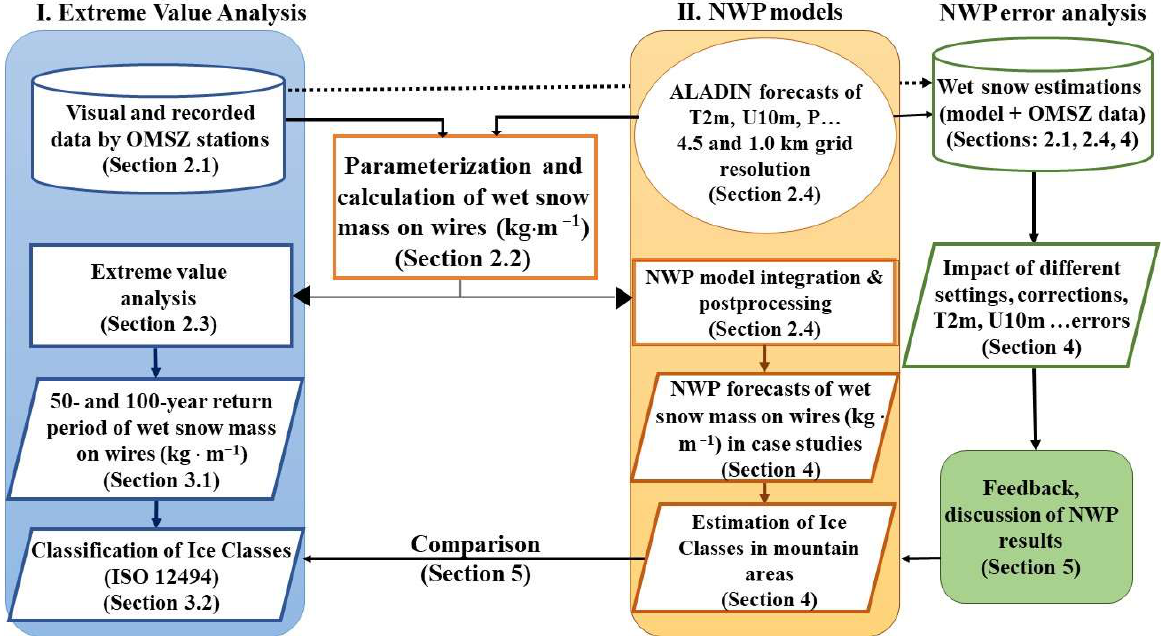
Figure 2. Flow chart of the applied methods and results. The abbreviations T2m, U10m and P mean 2 m temperature, 10 m wind and precipitation amount, respectively.